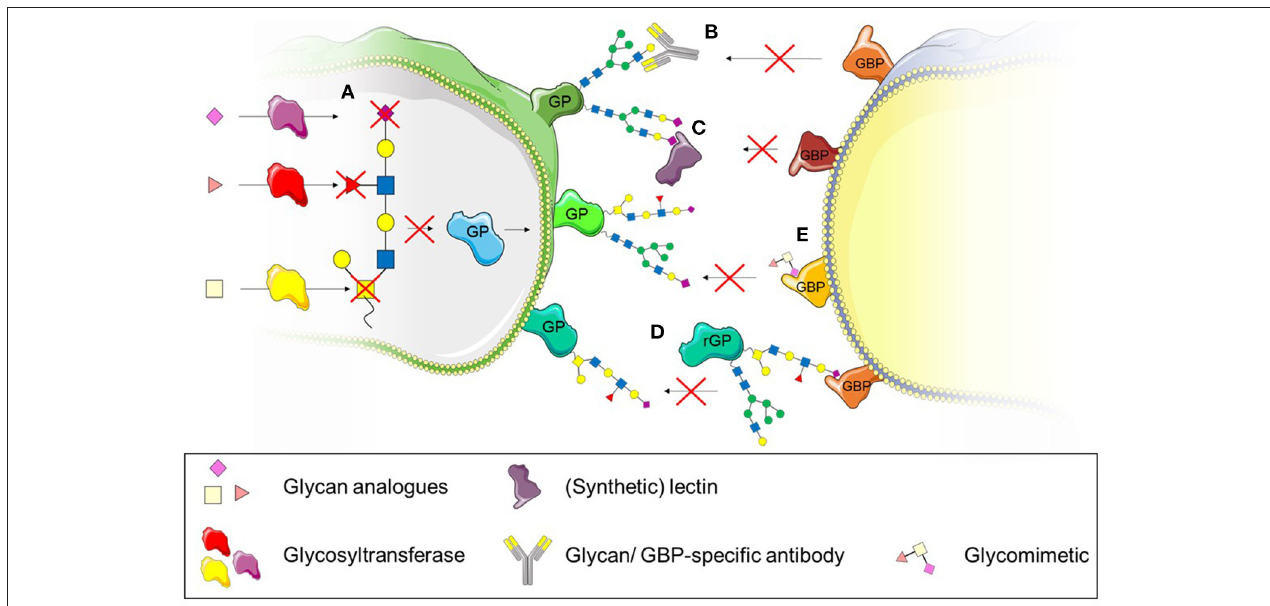
FIGURE 5 | Therapeutic strategies to interfere with leukocyte recruitment and transmigration. (A) The use of synthetic glycan substrates impairs enzyme-catalysed glycan formation and prevents recognition by glycan-binding proteins (GBP). (B) Specific antibodies targeting glycans can also be used to interfere with glycan recognition by GBPs. (C) (Synthetic) lectins bind to specific glycan structures and interfere with recognition by GBPs. (D) Recombinant glycoproteins (rGP) bind to GPBs and therefore prevent binding to native glycoproteins (GP). (E) Glycomimetics can also be used to bind to GBPs and prevent binding to